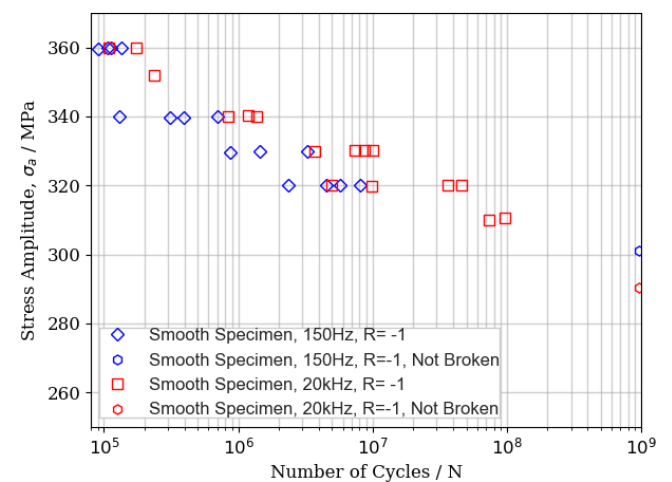
Figure 14: Test results for high strength steels at different loading frequencies [18], where the 150Hz test is conducted using traditional fatigue testing technique and the 20kHz test is conducted using ultrasonic testing